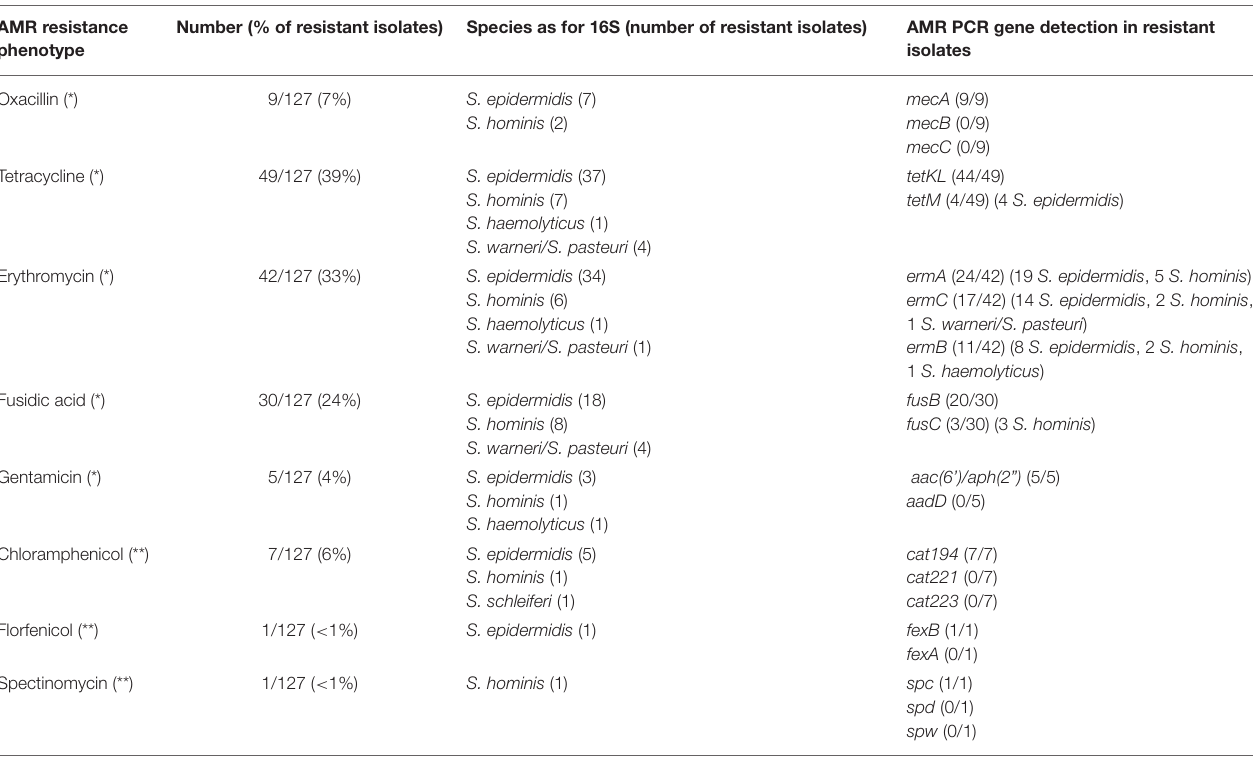
TABLE 1 | Antimicrobial resistance gene detection among phenotypically resistant CoNS isolates. AMR resistance